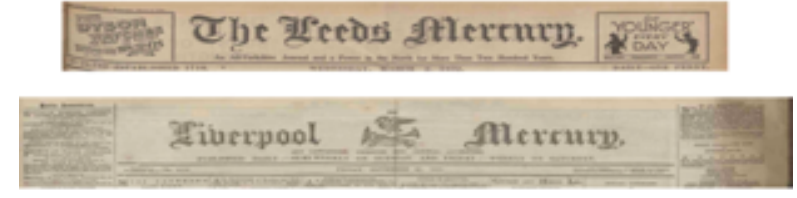
Fig. 1 Newspaper mastheads alluding to